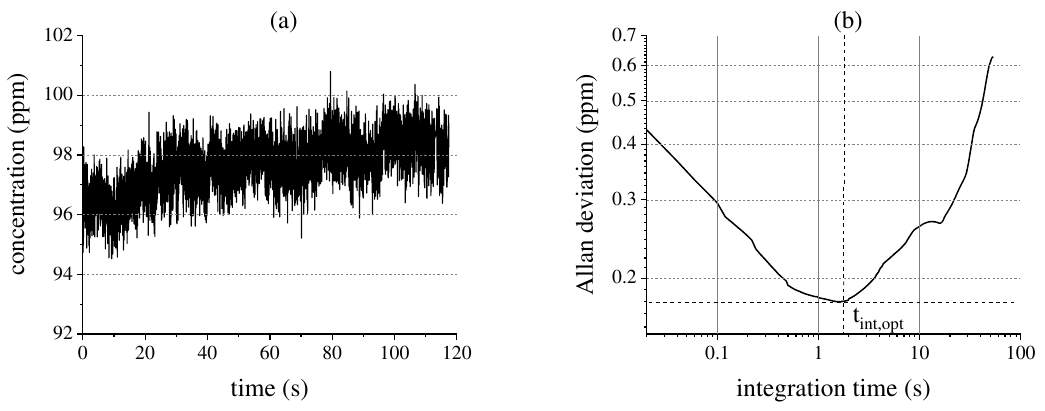
Figure 6. ( a ) Long-term gas measurement of a 100 ppm R134a probe with a measurement frequency of 50 Hz; ( b ) Corresponding Allan-plot in order to determine the ideal integration time.